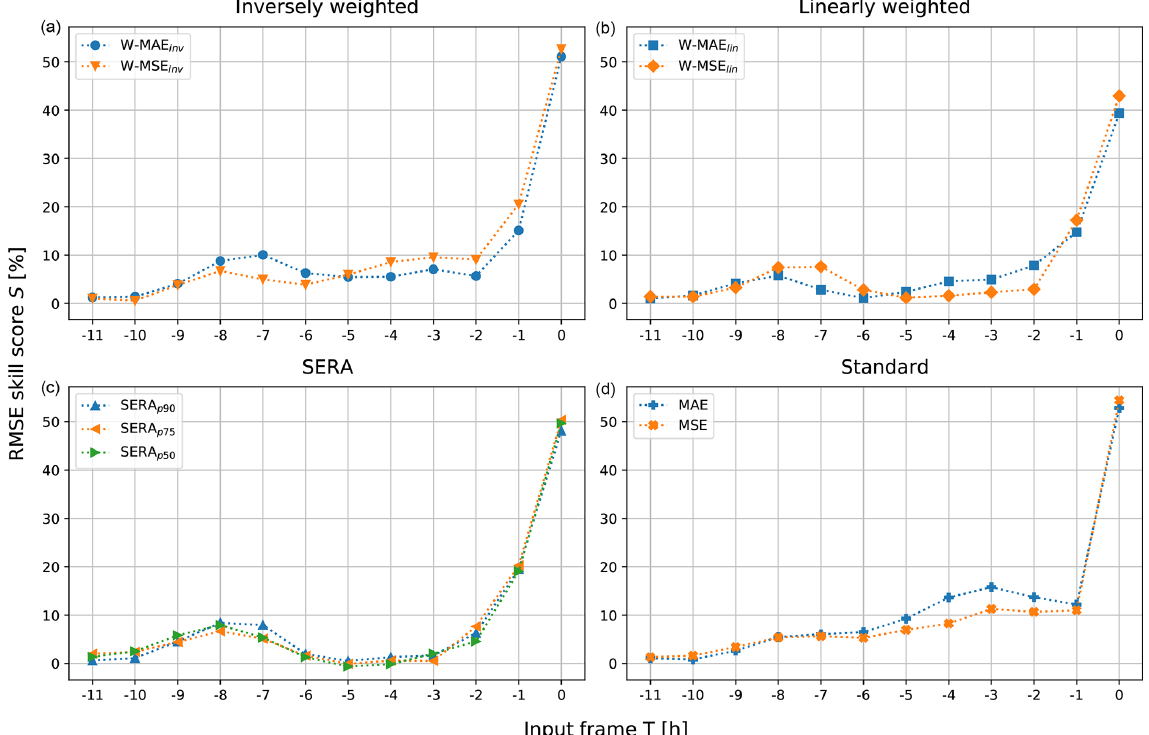
Figure 8. Results from the permutation tests. The figure shows the RMSE skill score (in %) between the targets and the normal predictions of each of the models and the targets and the predictions resulting from randomly permuting the inputs at time frame T . A score of 0% indicates no change in RMSE, a score of 100% indicates maximum increase in RMSE and negative scores indicate decrease in RMSE due to the permuted inputs. (b) The linearly weighted losses. (c) The SERA loss with different primary control points (with the secondary control point fixed at p 99 ). (d) The standard MAE and MSE